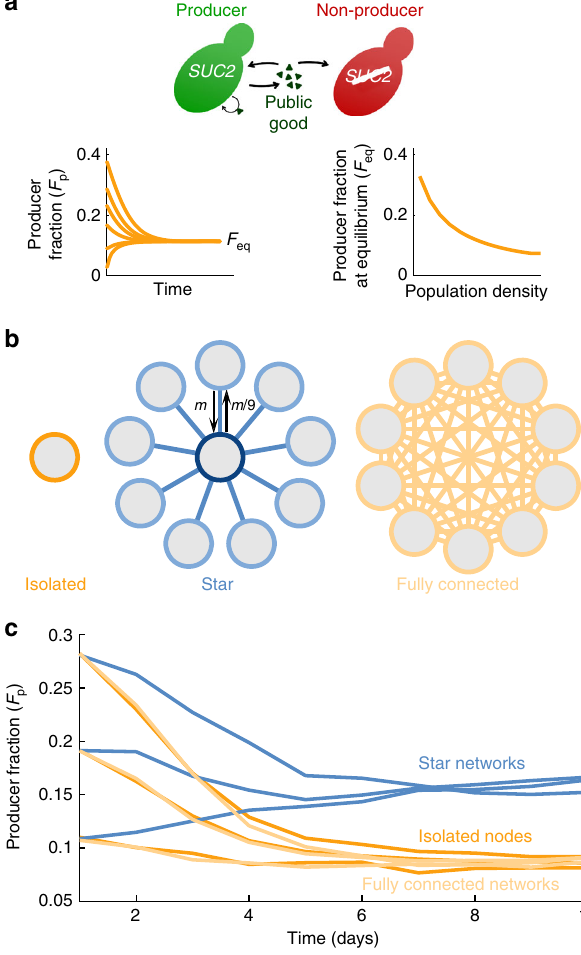
Fig. 1 Heterogeneous metapopulation structure increases the fraction of producers. a Schematic of the public-goods game. Producers (green) produce a public good (triangles), keeping a small fraction (~1%) for themselves and releasing the rest, which also bene fi ts non-producers (red). Left inset: Illustration of the time evolution of the fraction of producers ( F p ) in a well-mixed population. Right inset: Illustration of the dependency of the equilibrium fraction of producers ( F eq ) on the density of a well-mixed population. Both illustrations were computed using the model in Fig. 2. b Migration scheme for isolated nodes (no migration), star networks (all side nodes send a fraction m of migrants towards the central node, which in turn sends a fraction m /9 towards each side node), and fully connected networks (every node sends a fraction m /9 of migrants towards each other node). c Experimental results showing the fraction of producers (computed as total number of producers over total number of cells for the whole network) as a function of time for the three network topologies, starting from three initial conditions. Each line corresponds to one 10-node network (or 10 isolated